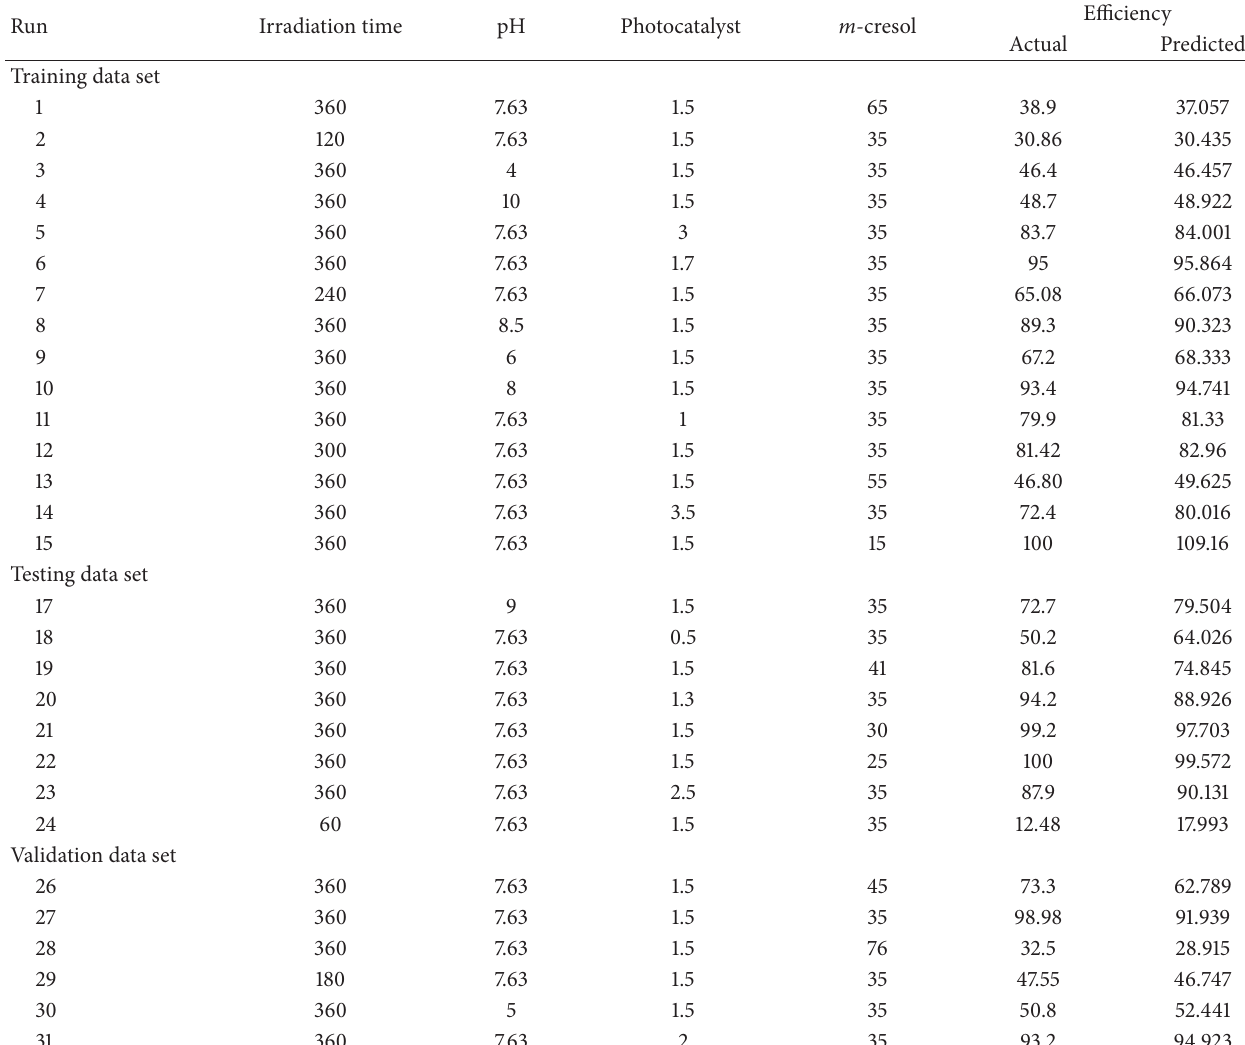
Table 1: The training, testing, and validation data sets of the effective variables and actual and models predication efficiency of m -cresol photodegradation by Mn doped ZnO